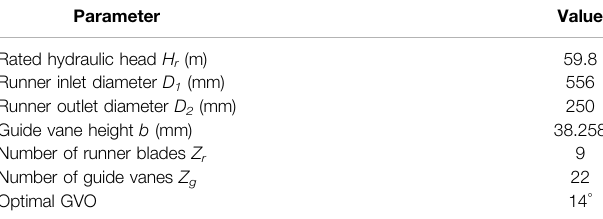
TABLE 1 | Table of basic geometric parameters of model. Parameter